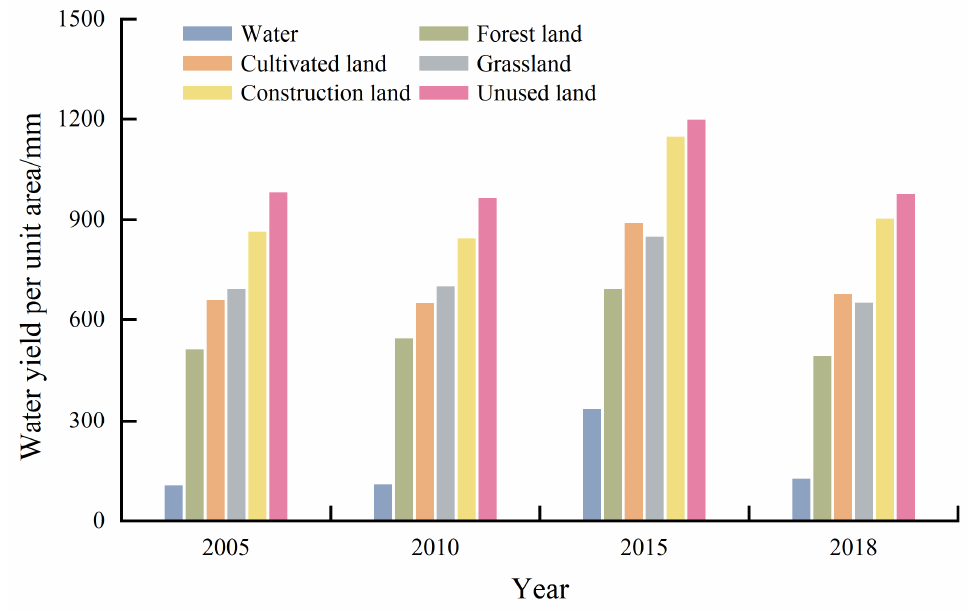
Figure 4. Water yield per unit area of each type of land.